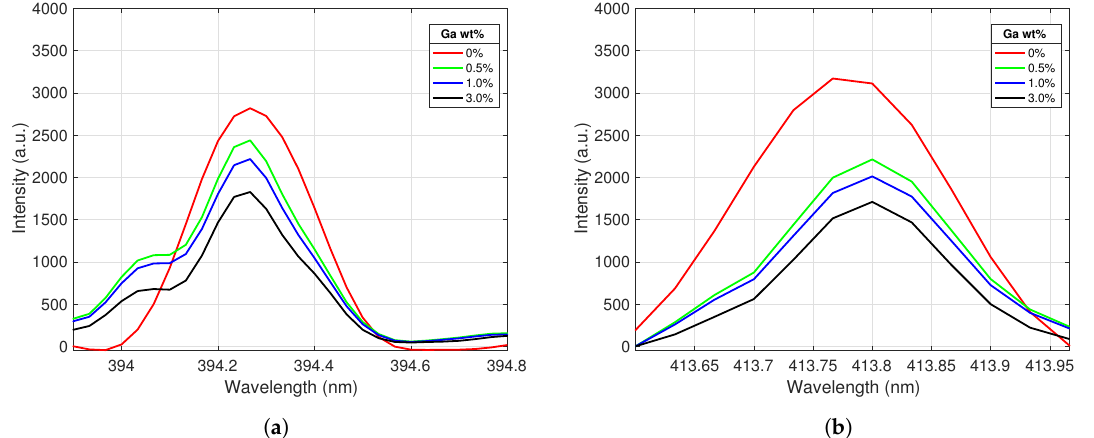
Figure 4. Ce II emission peaks centered at ( a ) 394.3 nm and ( b ) 413.8 nm. The peak intensities decrease as the Ga concentration in the alloy